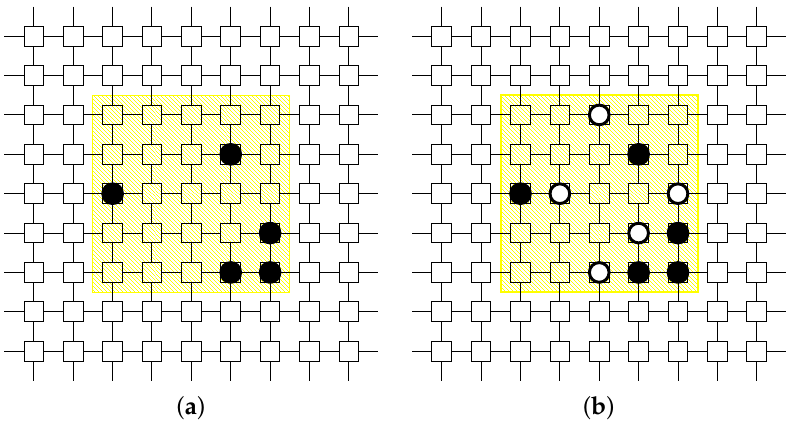
Figure 6. Application example of machine learning tactic for Unknown Zone. ( a ) Before. The yellow area represents an Unknown Zone. ( b ) After. The white-hat worms are placed according to the prediction of the given machine learning